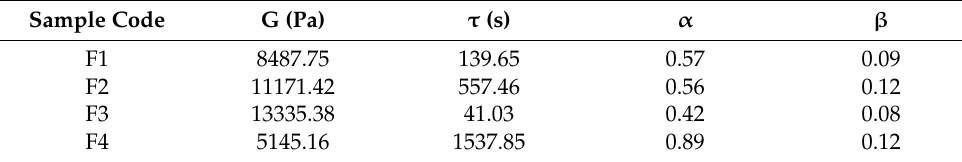
Table 4. Estimate of the Maxwell fractional parameter with the two spring-pot